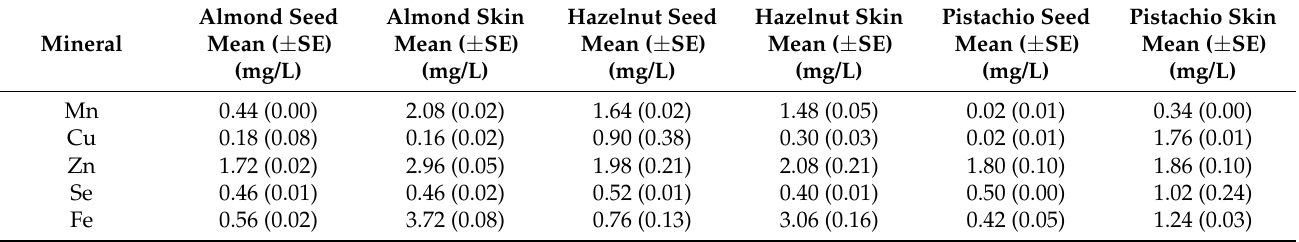
Table 2. Mineral content (mg/L) in 1.0 g of seeds and skins of almonds, hazelnuts, and pistachios.